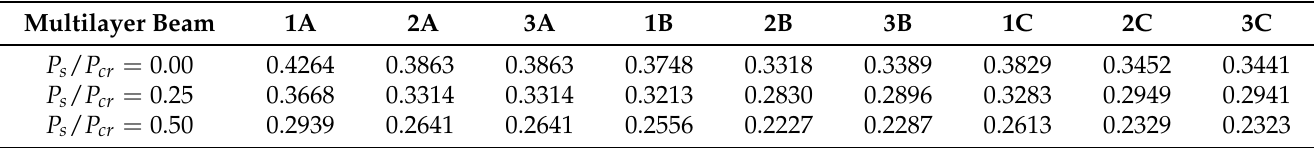
Figure 8. Effect of GPL weight fractions Λ GPL and normalized static axial force P s / P cr on the dimensionless fundamental frequency. Table 6. Effect of normalized static axial force P s / P cr on the dimensionless fundamental frequency under porosity distributions and GPL patterns ( e 0 = 0.5 , Λ GPL = 1.0 wt.% , C-C, L / h = 20, ∆ T = 0 K , K w = K s = 0).